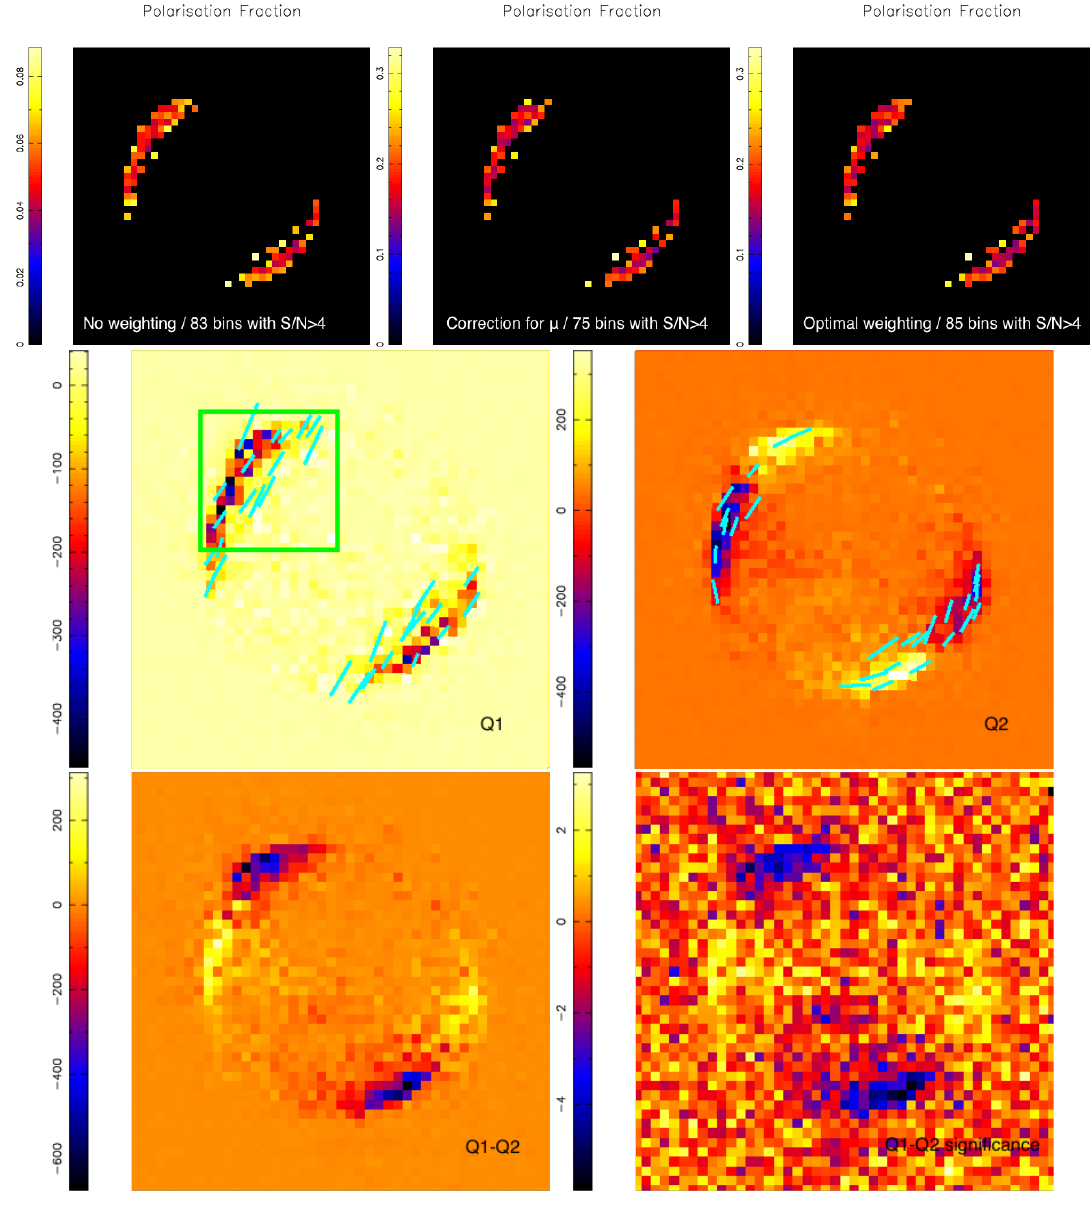
Figure 8. Monte Carlo simulations of SN 1006 in 2–8 keV band based on 1 Ms exposure of each position with XIPE. The output images are binned to 64 (cid:48)(cid:48) pixels. ( Top panels ) the polarisation fractions corresponding to the three weighting methods: no weighting, correction for µ and an optimal weighting. A radial magnetic field is assumed for the two images. ( Middle panels ) the simulated Stokes Q images using optimal weighting for parallel ( left ) and radial magnetic field ( right ) configurations, respectively, overlaid with polarisation vectors (cyan bars) and the field of view of XIPE (green box). ( Bottom panels ) a difference map for the Q images in the middle panels and the significance map of the difference image on the